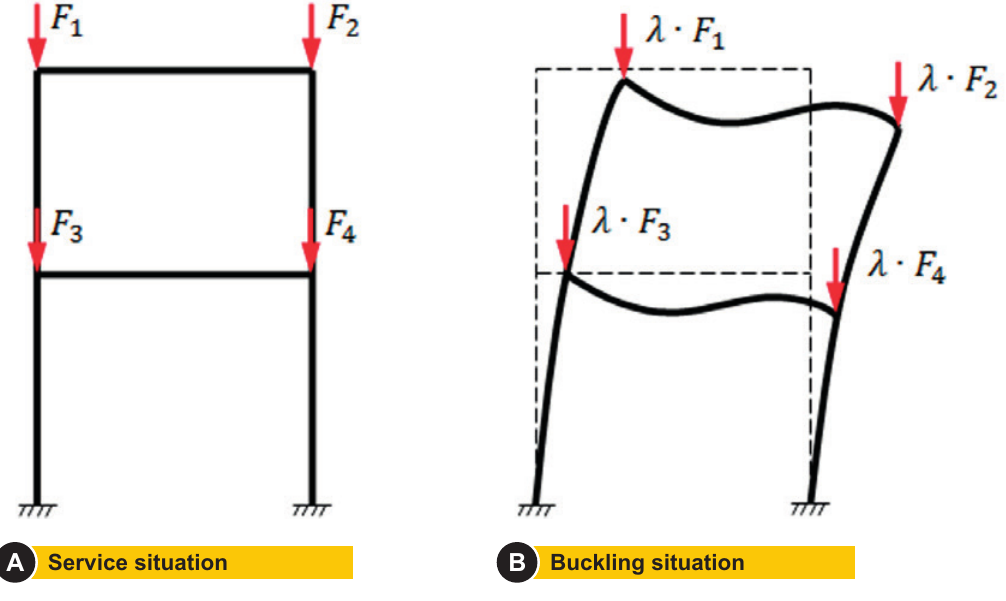
From: OLIVEIRA [11], adapted by the author.